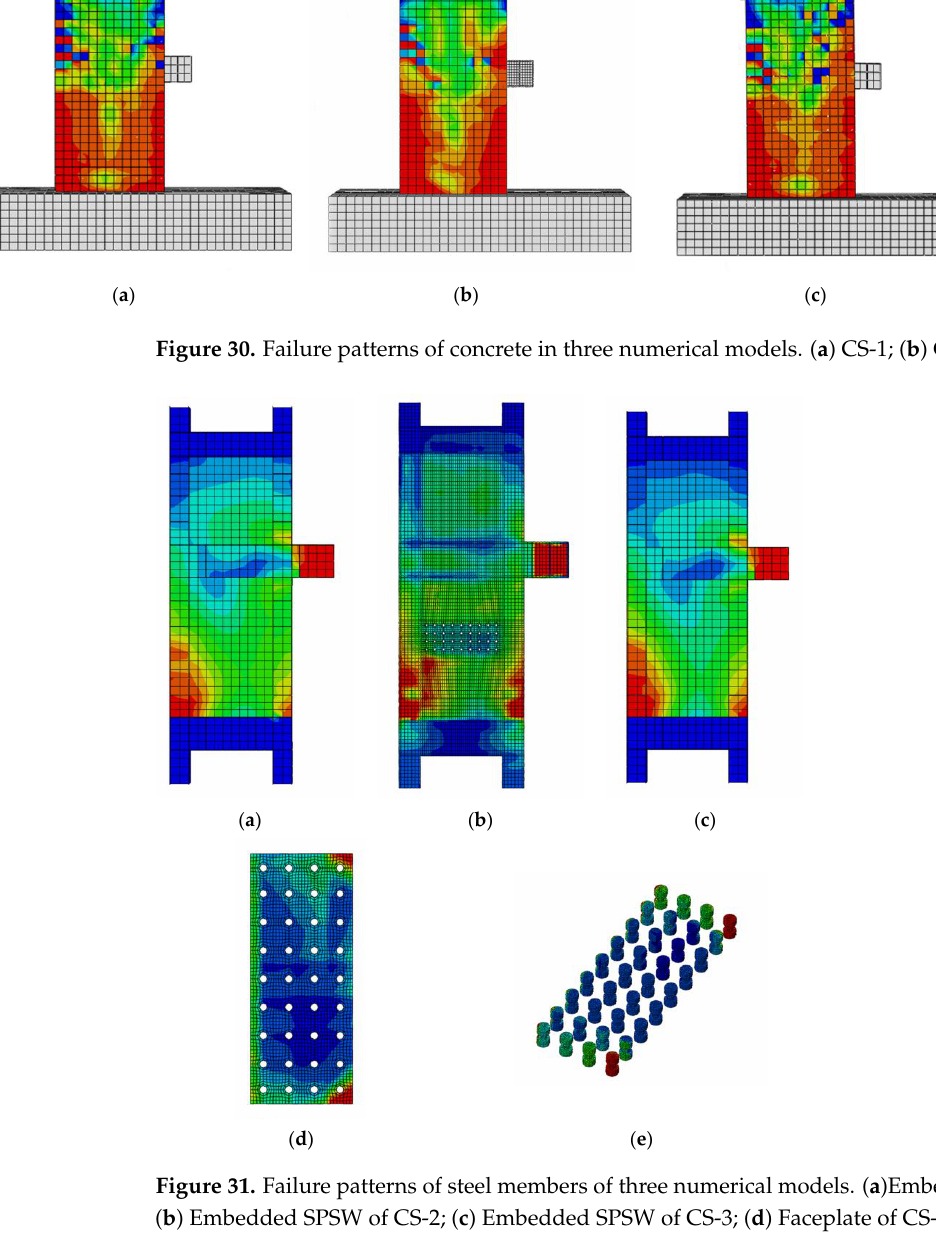
( c ) Figure 32. Failure patterns of steel bars of three numerical models. ( a ) CS-1; ( b ) CS-2; ( c ) CS-3. 5. Conclusions Through the structural test and the FE analysis, three 1/3-scaled C-SPRC wall subas- semblies with different embedded SPSW details and wall shear-span ratios were